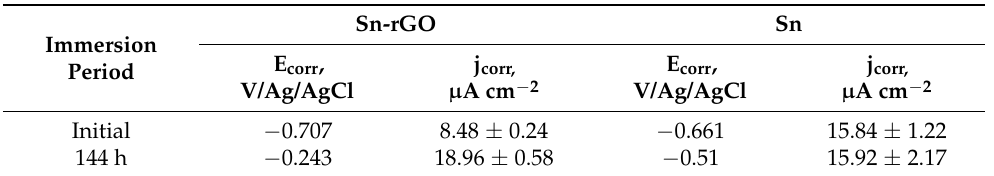
Table 3. Values of corrosion parameters from polarization curves in 0.5 M NaCl for Sn-rGO and Sn coatings after different conditioning